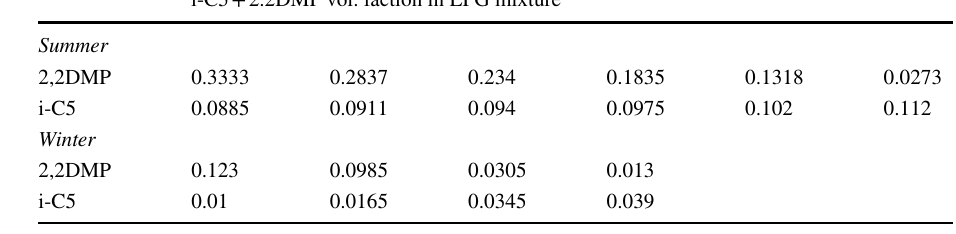
i-C5 + 2.2DMP vol. faction in LPG mixture